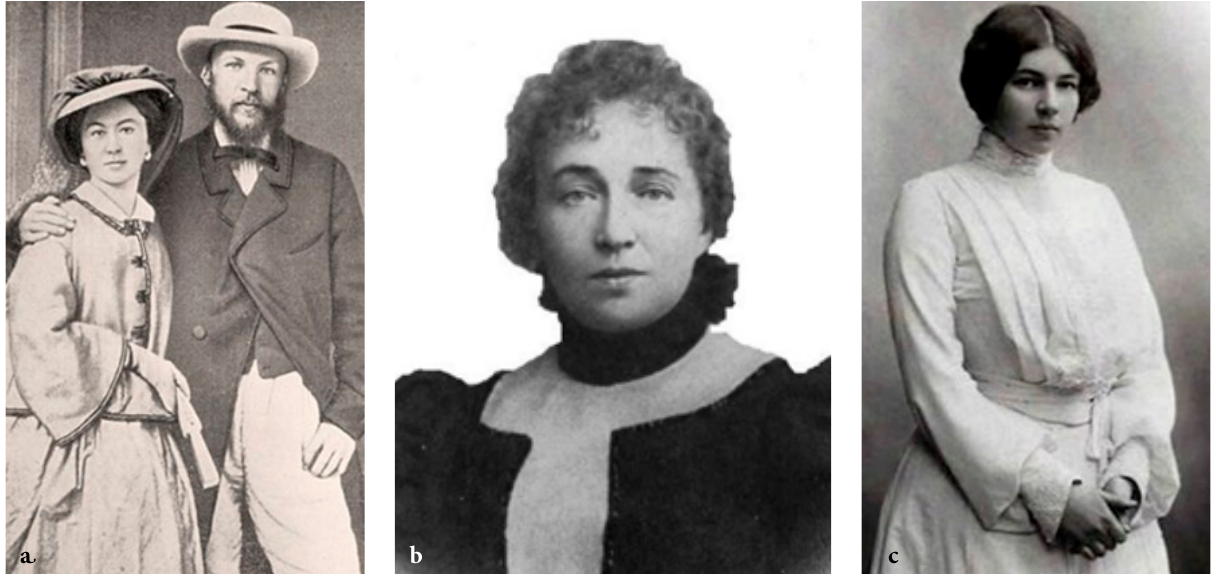
Figure 3. Ladies of Mendeleev’s family: Mendeleev with his first wife Feozva Leshcheva (a); Anna Popova – his second wife (b); c – Mend- eleev’s daughter Lyubov (permission of the Museum and archives of Dmitri Mendeleev in St.